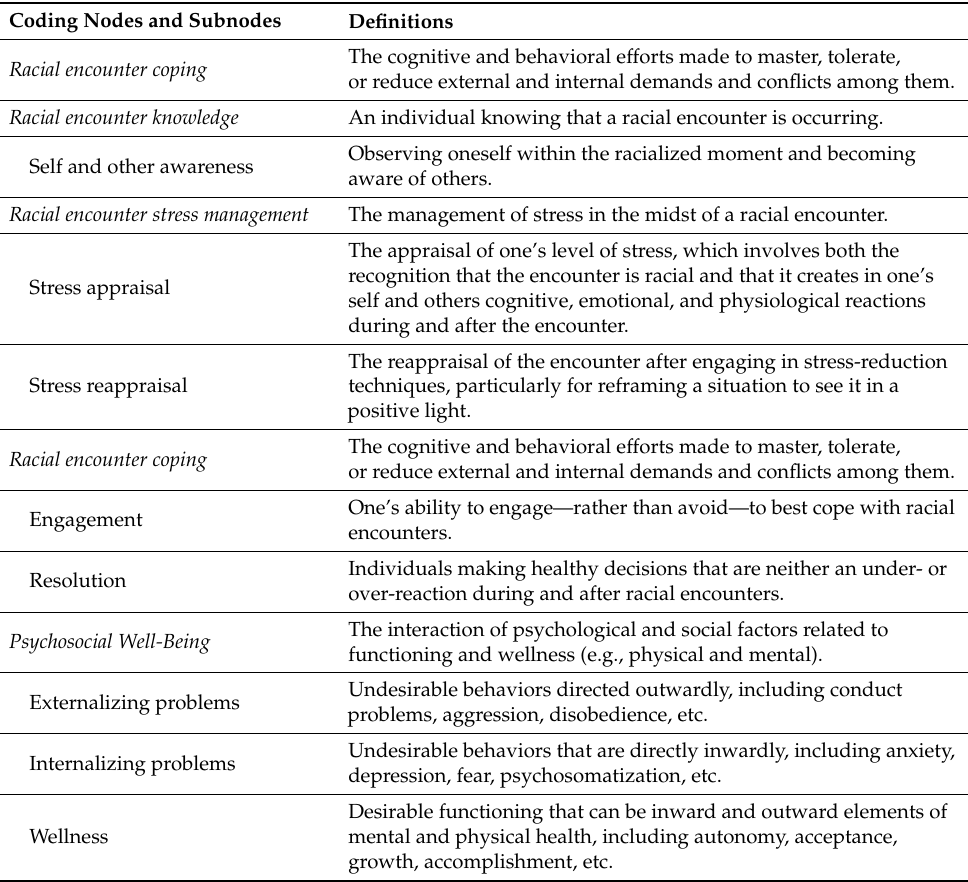
Table 2. Nodes and subnodes of qualitative